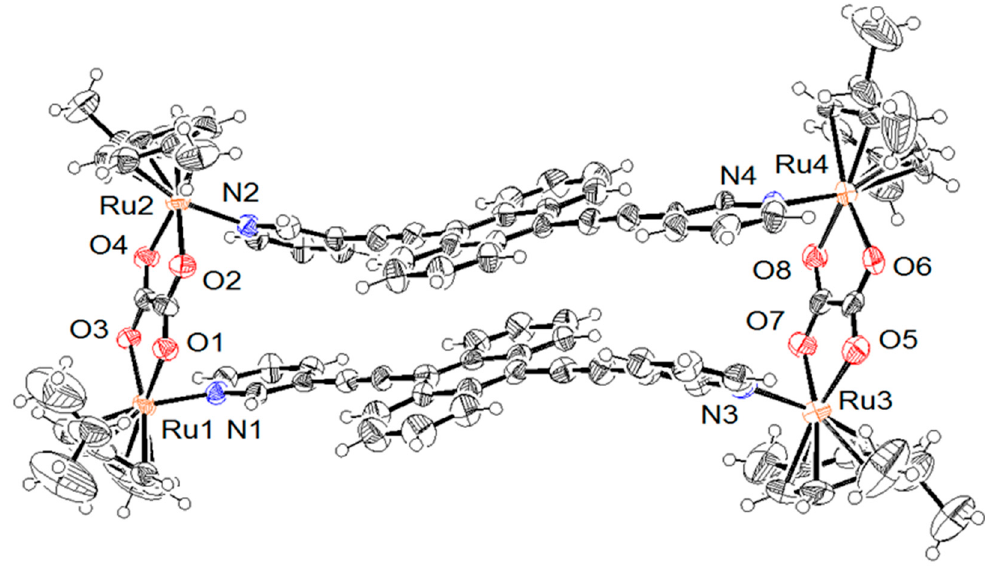
Figure 4. Molecular structure of A 1 · 4 acetone at 50% probability level ellipsoids. Trifluoromethanesulfonate and acetone molecules omitted for clarity.